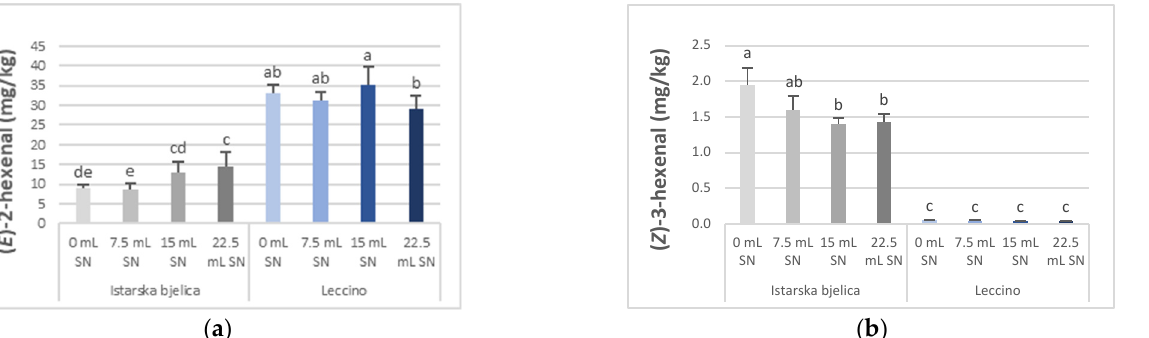
Figure 2. Multiple comparisons of the effects of treatment (T) (0, 7.5, 15, and 22.5 mL of the applied SN foliar fertilizer per 1 L of water) and cultivar (Cv.) (Istarska bjelica, Leccino) on the concentration of ( a ) ( E )-2-hexenal, and ( b ) ( Z )-3-hexenal. Different superscript lowercase letters represent statistically significant differences between the mean values at p < 0.05 that were obtained by a three-way ANOVA and Tukey’s test. Table 2. The effect of treatment (T) (0, 7.5, 15, and 22.5 mL of the applied SN foliar fertilizer per 1 L of water), cultivar (cv.) (Istarska bjelica, Leccino), and collection year (Y) (2019, 2020) on the concen- trations of volatile compounds in olive oil.